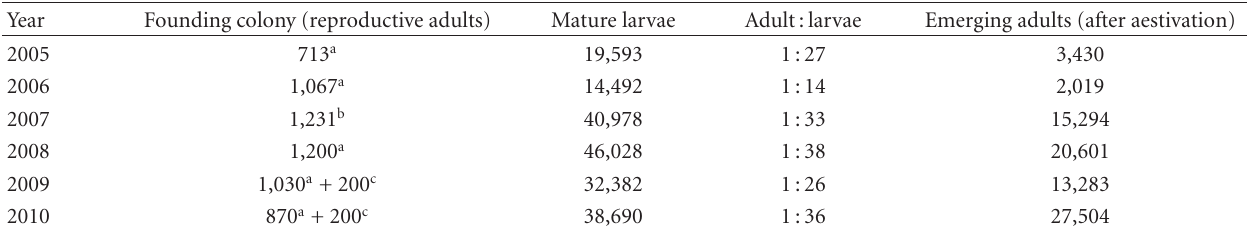
Table 3: The number of Laricobius nigrinus in each life stage at the Virginia Tech Insectary from 2005 to 2010. Year Founding colony (reproductive adults) Mature larvae